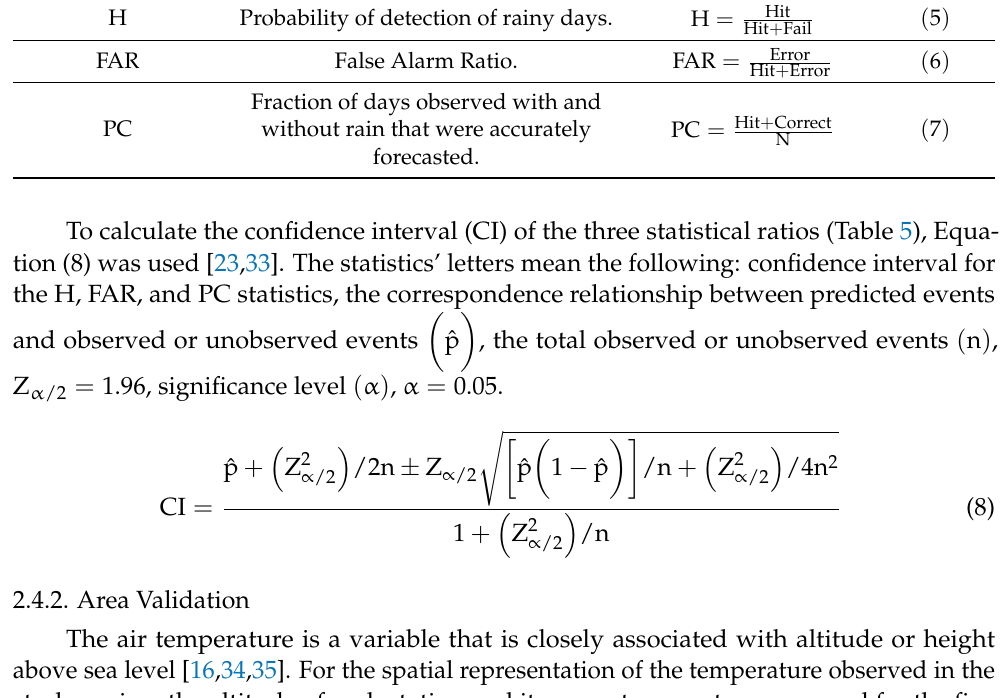
Table 5. Statistical ratio for precipitation validation [30]. The ratio, a short description, and its equation are indicated. N = Total observed and unobserved events. Ratio Description Equation H Probability of detection of rainy days.